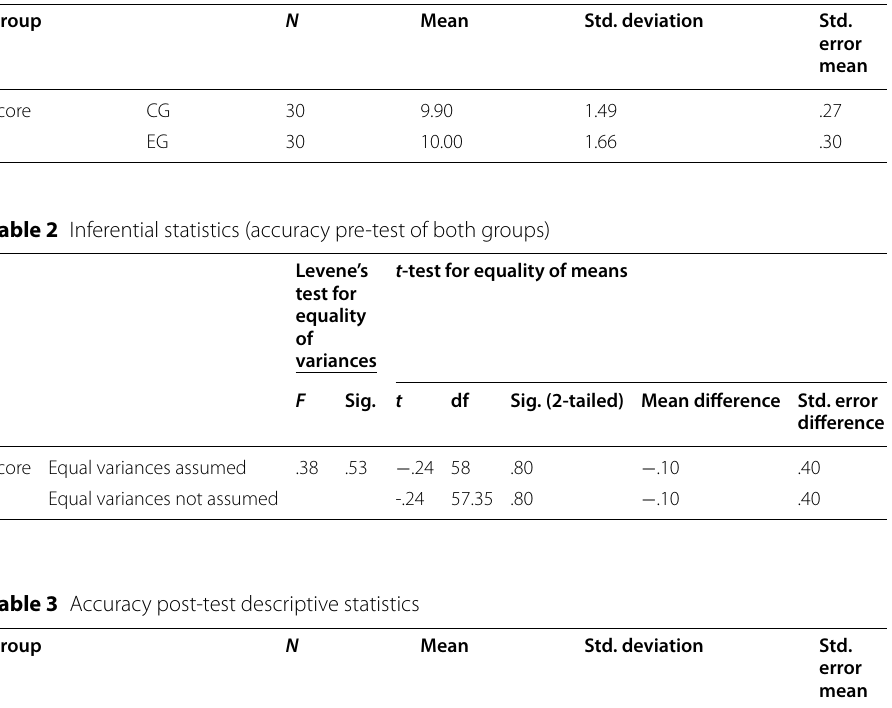
Table 1 Accuracy pre‑test descriptive statistics